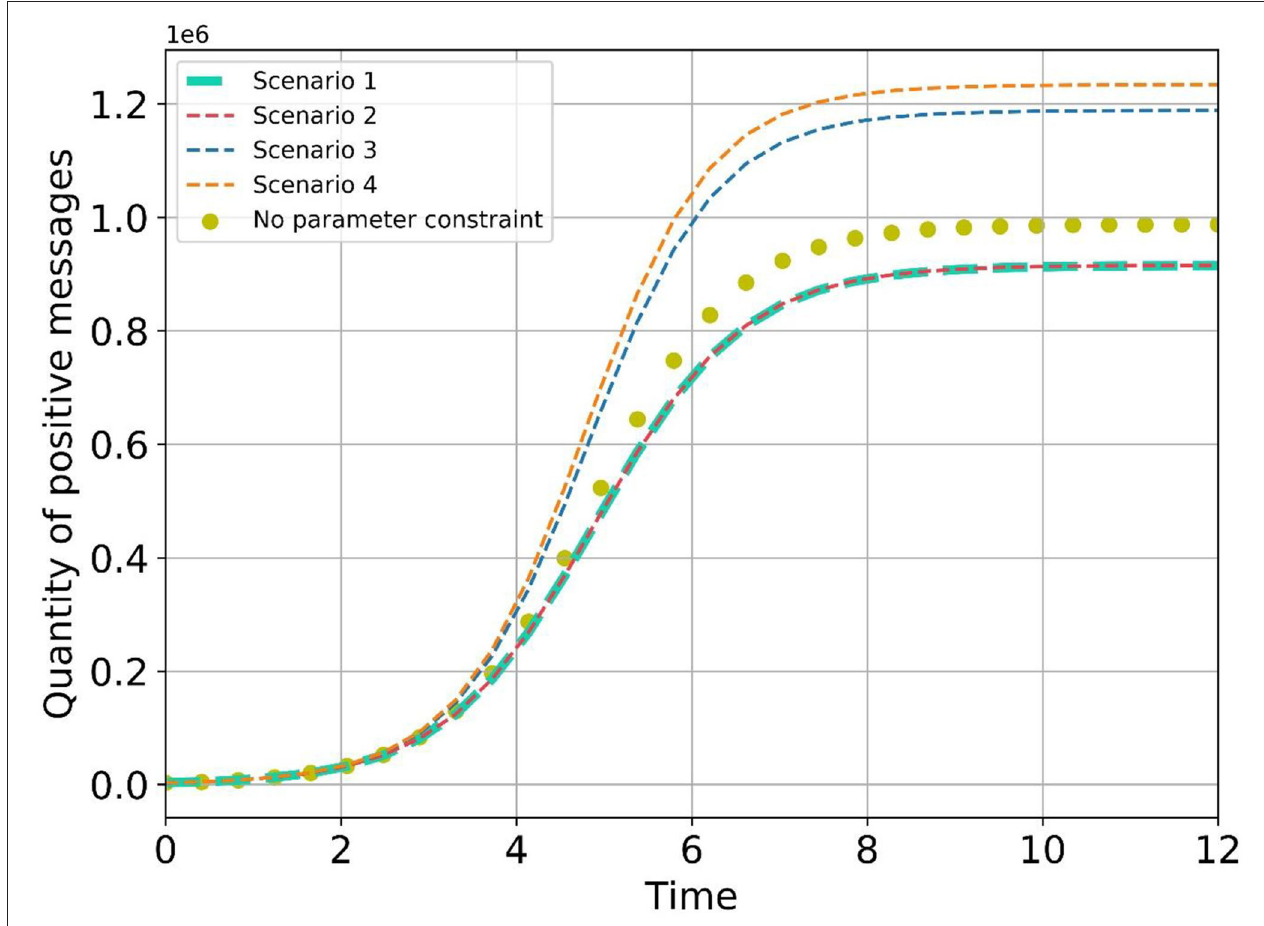
FIGURE 17 | Evolution curves of positive information in different scenarios.